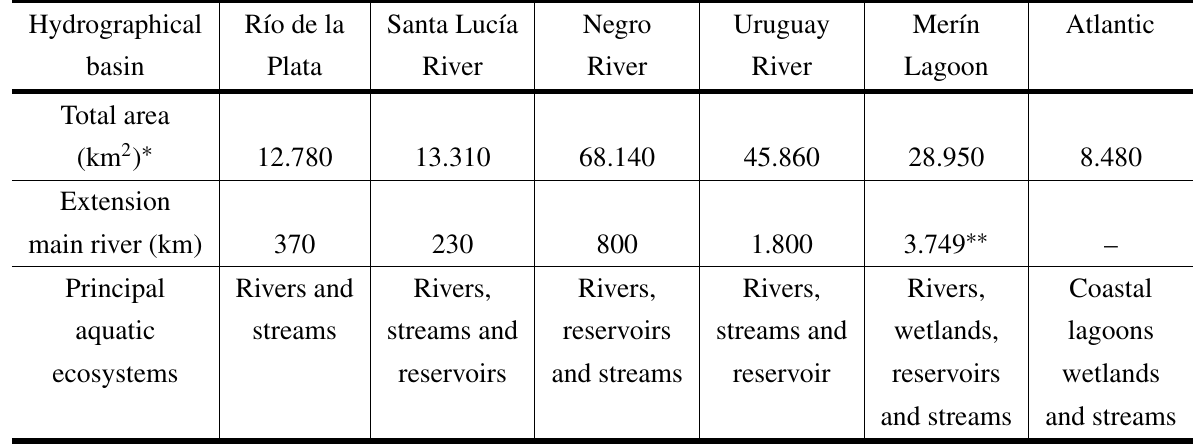
Main characteristics of the Uruguayan hydrographical basins.